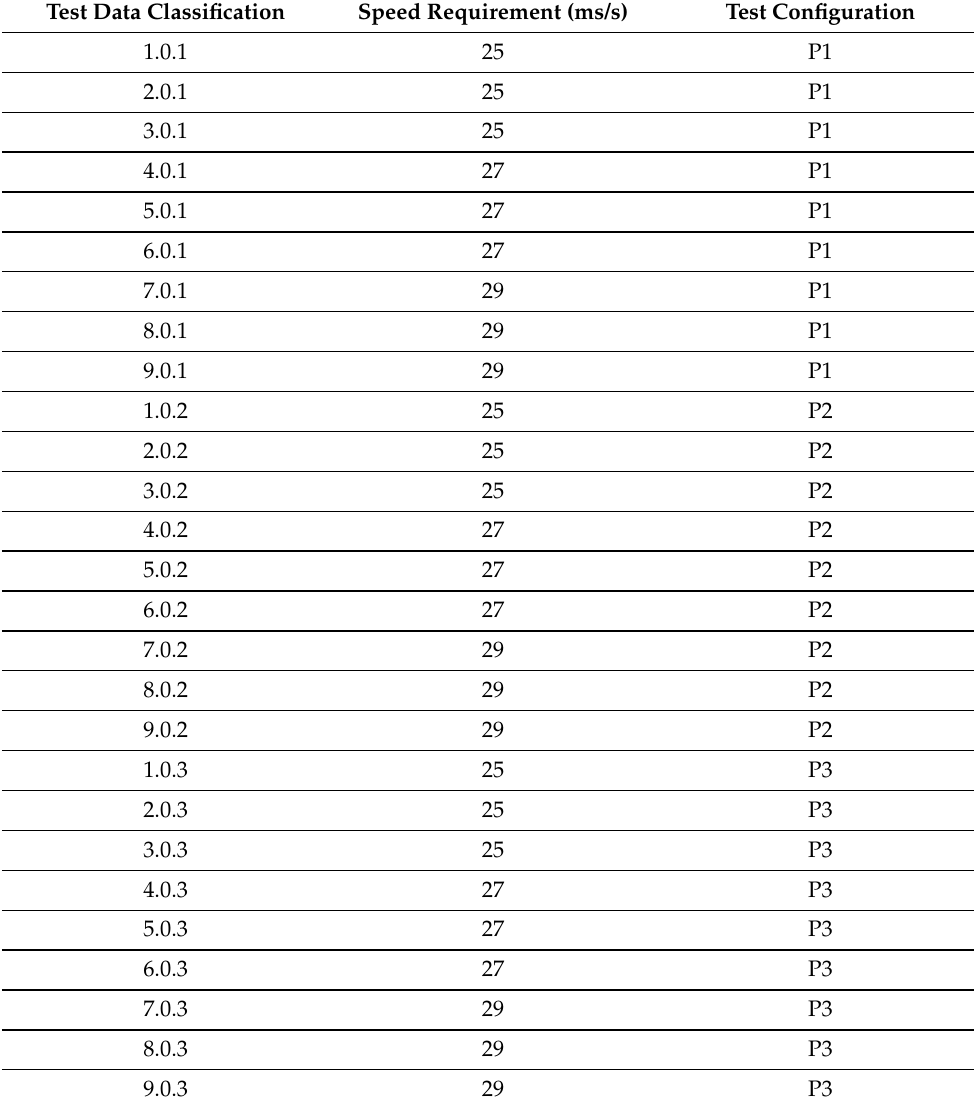
Table 1. Test data classification system for field test data